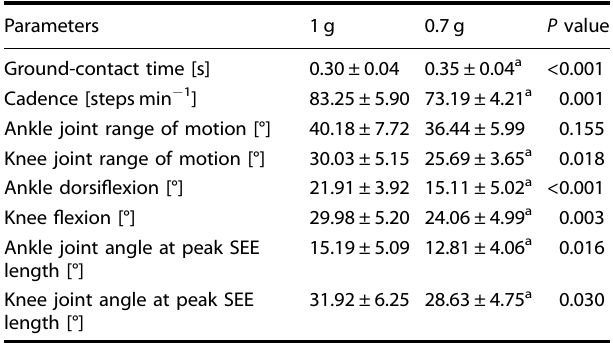
Table 1. Spatio-temporal and kinematic parameters while participants ran at 125% of their preferred walk-to-run transition speed at 1 g and simulated 0.7 g.